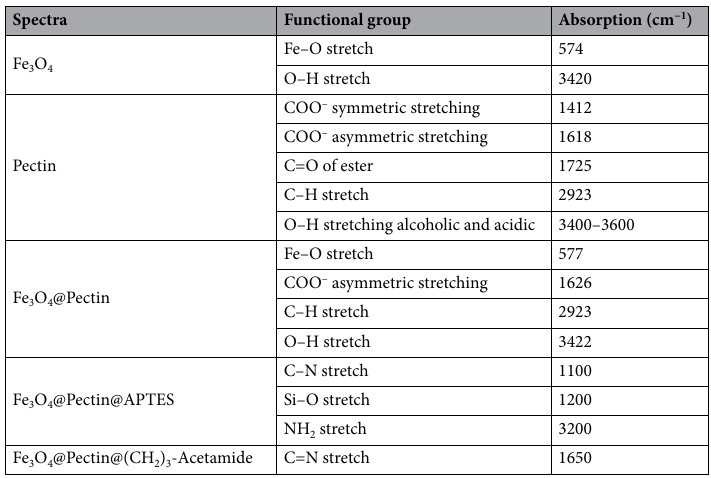
Table 1. FT-IR characteristic absorption of Fe 3 O 4 @Pectin@(CH 2 ) 3 -Acetamide-Cu(II) catalyst components.